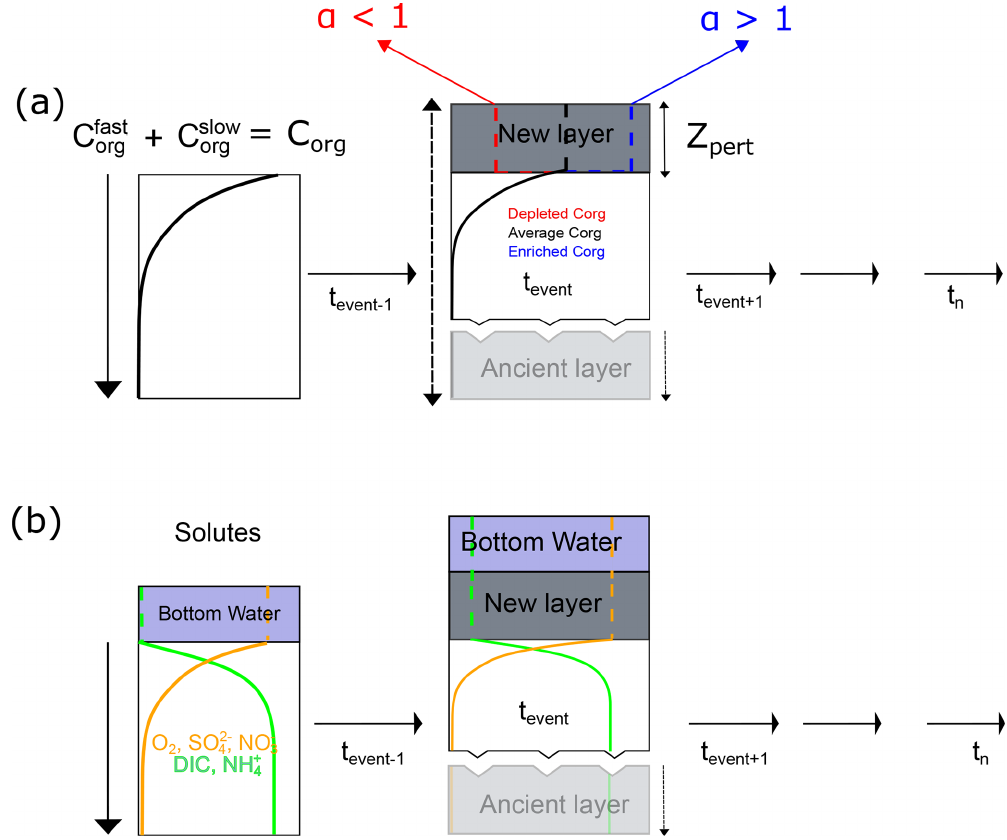
Figure 2. Schematic of model implementation for the deposition event scenario. Profile from previous time step (left) and after addition of new layer over a predefined depth layer (right). For the solid (a) , the new layer can be enriched (blue) or depleted (red) relative to the old (average) (black). The dissolved substances (b) are set equal to the bottom water concentration during the deposition. Thereafter, the profile is integrated forward with time. The whole sequence of step occurs dynamically with time capitalizing on the integrator ability to simulate dynamic event process. α is the carbon enrichment factor applied over depth Z pert (see text for